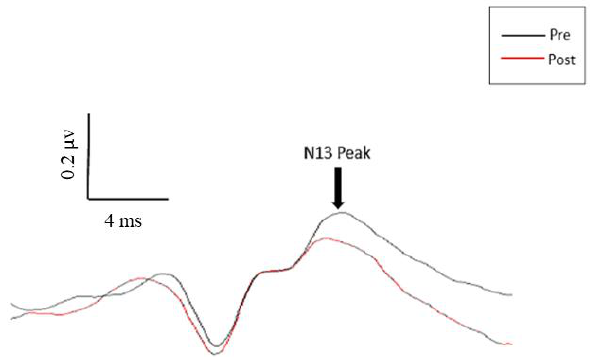
Figure 5. Pre- and post-tracing intervention SEP peaks for one representative participant. The black trace is the pre-intervention trace; the red trace is the post-intervention trace. Note the large decrease in amplitude for the N13 peak.